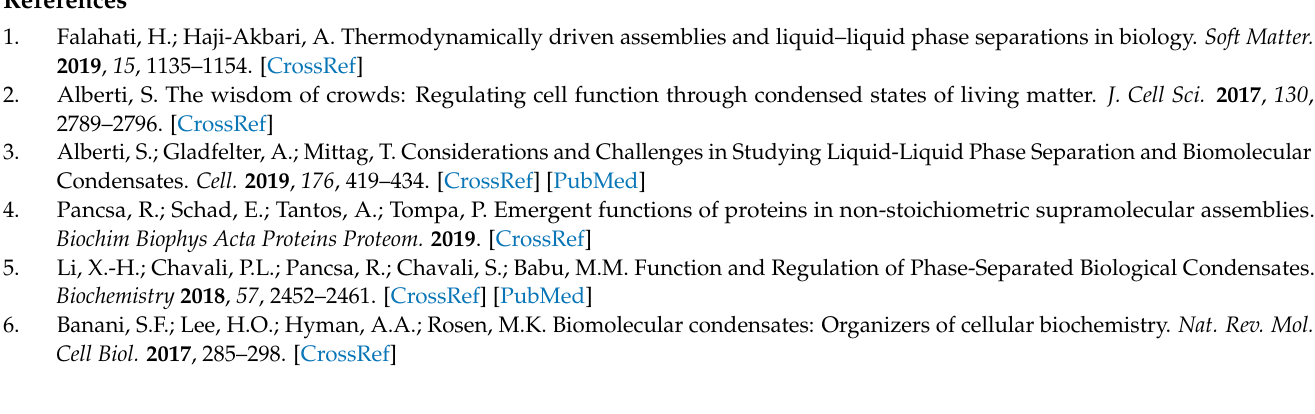
Figure S2: The lowest protein concentrations applied in in vitro LLPS experiments frequently exceed those calculated from proteomics-derived highest cellular protein abundances, Figure S3: The genes of human LLPS driver proteins are overrepresented among ohnologs but not among copy number- conserved genes, Figure S4: Lack of enrichment in transcription factors among LLPS driver genes, Table S1: List of 251 potential LLPS drivers from all organisms (before filtering) derived from the different resources and depicted in Figure 2A, Table S2: List of 89 confident human LLPS drivers derived from the different resources (depicted in Figure 2C), Table S3: In vitro concentration data with sources and information on the protein constructs, Table S4: Sources of concentration data (in vitro, proteomics-derived and estimated) used in the analysis and depicted in Figure 3, Table S5: Dosage sensitivity features of human proteins from the reviewed human proteome of UniProt, Table S6: Dosage sensitivity features of the 89 confident LLPS drivers, Table S7: Dosage sensitivity features of genes in the randomly selected well-annotated gene